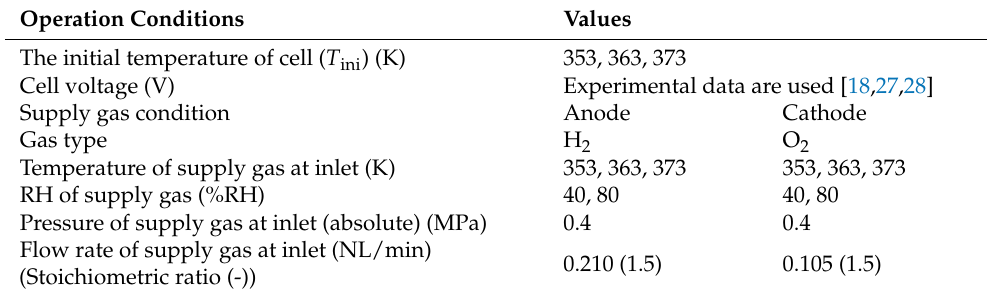
Table 3. Operation conditions for power generation applied for the numerical simulation in this